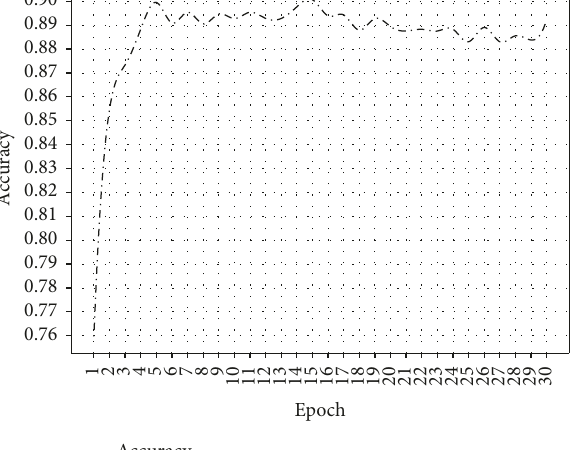
Figure 5: Schematic diagram of evaluation index accuracy changes.